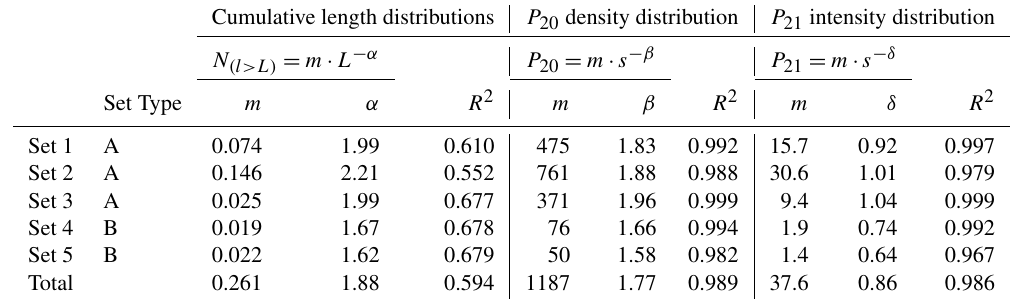
Table 5. Summary table reporting the power-law scaling and the values of the related parameters retrieved from the multiscale analysis of cumulative length distribution, lineament density, and